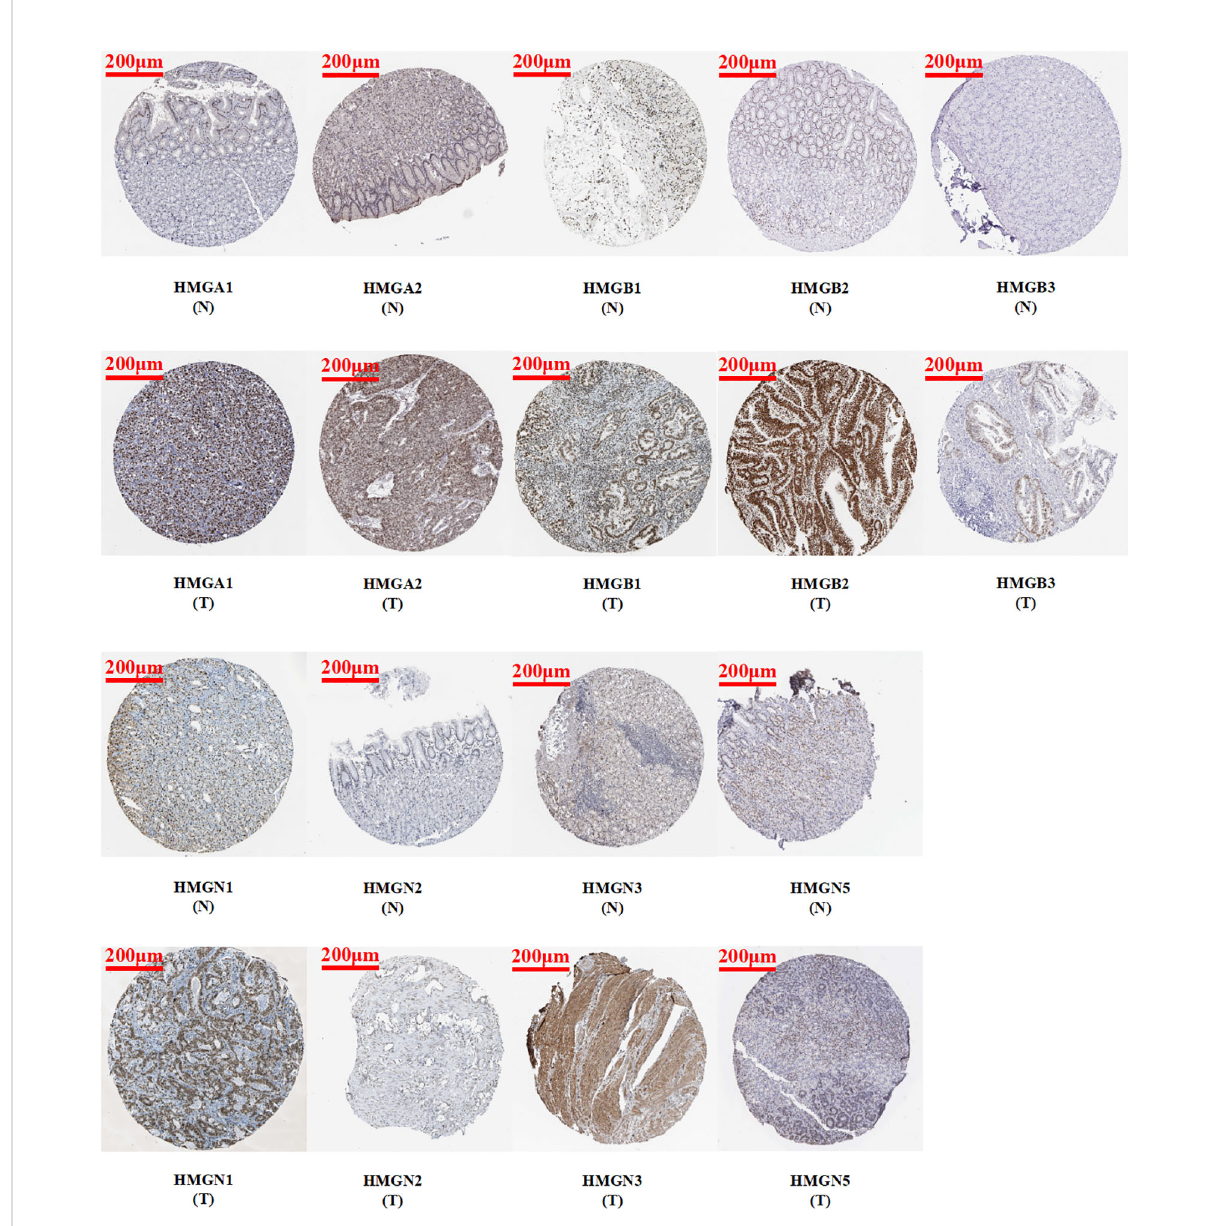
FIGURE 3 Protein expression levels of HMGs in GC. Images of immunohistochemistry staining for GC and normal tissues were collected with HPA. The greater the antigen content (representing the level of protein expression) and the higher the distribution density, the stronger the positive result color rendering. According to the degree of color rendering of positive markers, they are classi fi ed as: blue, negative; light yellow, weakly positive; brown, moderately positive; and dark brown, strongly positive. (scale bar = 200 m